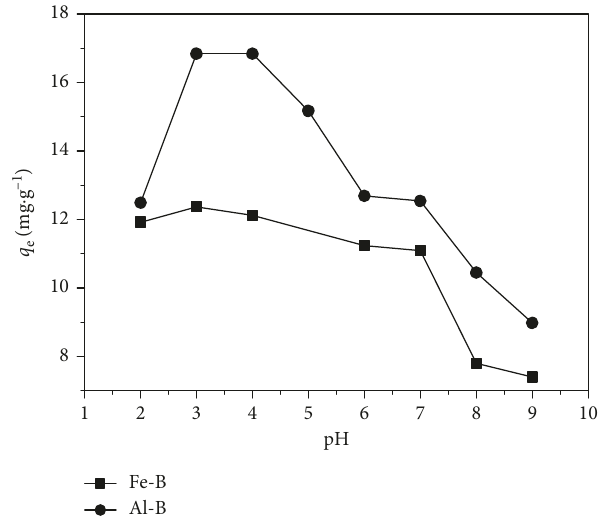
Figure 5: Effect of pH on the adsorption capacity of As(V) onto Fe-B sample ( C o(As) � 12.98mg/L) and Al-B sample ( C o(As) � 16.84 mg/L) ( T � 303K, m � 0.05g, t �